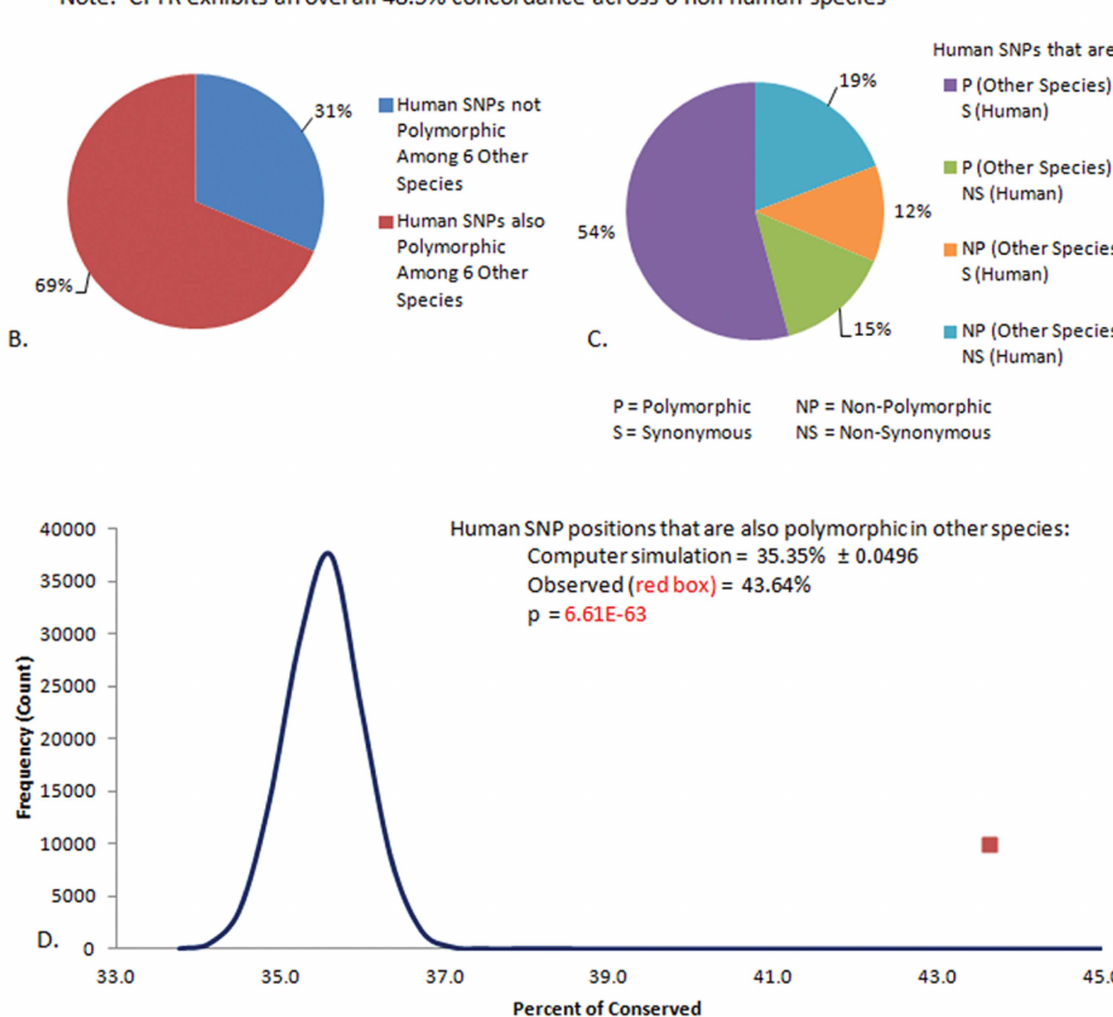
Figure 4. Positions exhibiting polymorphism in human CFTR are also polymorphic among other species. A: Six of nine CFTR coding SNPs identified by unbiased analysis of individuals in 1000 Genomes were also were polymorphic among diverse species, despite approximately 50% overall nucleotide identity among the non-human CFTRs being analyzed. B, C: CFTR and 21 other genes (Table S3) were investigated in the same fashion shown in Panel A. The majority of SNPs in exonic regions found to be polymorphic were synonymous ( p =2.7 6 10 2 9 , versus the stochastic ratio otherwise expected for non-synonymous to synonymous polymorphism). In order to increase stringency, only those genes in Figure 2A with $ 50% concordance across the six non-human species were included in the analysis. D. CFTR homologs in four evolutionarily distant species (horse, frog, zebrafish, and shark) were aligned with the human coding strand, both independently and collectively. In the collective alignment, , 43% of the coding sequence was invariant. A computer simulation was conducted and the total number of differences from human placed randomly within the human CFTR reading frame of 4443 bp. The goal was to determine in a conservative fashion whether concordance observed in a multiple species